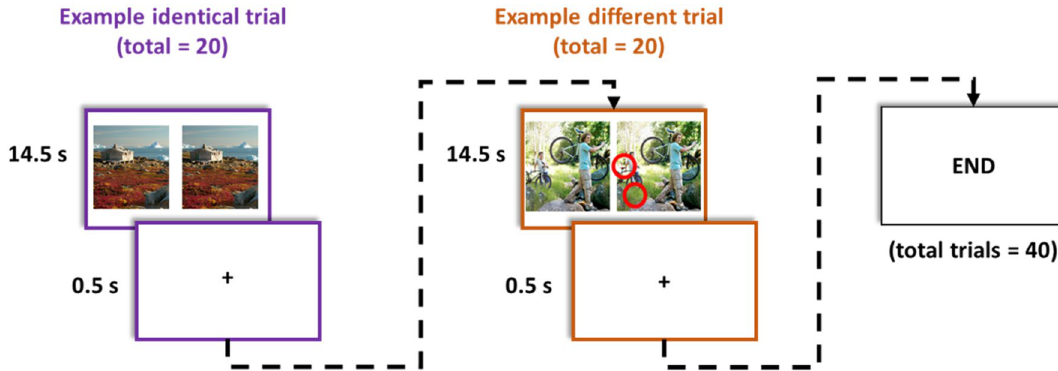
Figure 3. Scene discrimination task. Participants completed a total of 40 scene discrimination trials in this task. Each trial was 14.5 s in duration and separated by inter-stimuli intervals that were 0.5 s long. A different pair of photos of complex real-world scenes (e.g., countryside) was presented in each trial. Presented photo pairs were either identical (‘identical’ trials, total = 20) or contained two subtle differences (‘different’ trials, total = 20). Participants were required to search for possible differences between the two photos and to press the ‘spacebar’ on the computer keyboard when a difference was discovered. Red circles show the location of differences in the example of a different trial. The content of the identical and different scenes was visually and semantically different from the photos of everyday items in the long-term memory test. Photos were a modified version of a ‘spot-the-difference’ game designed initially as a filler task in memory consolidation paradigms (Dewar et al. 35 ; Craig and Dewar 16